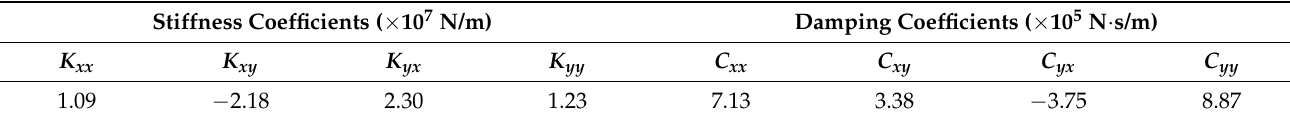
Figure 6. Variation tendencies of the dynamic coefficients for different sliding bearing lengths L b .